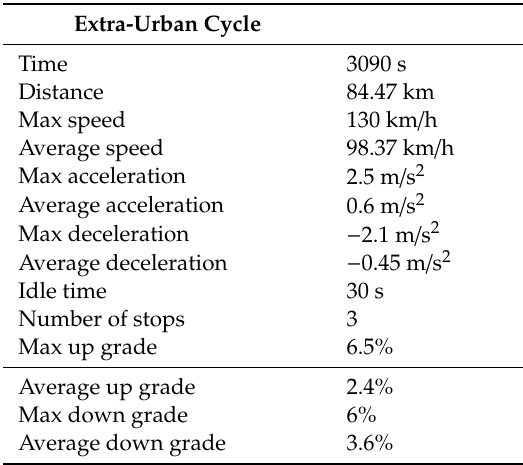
Table 16. Extra Urban